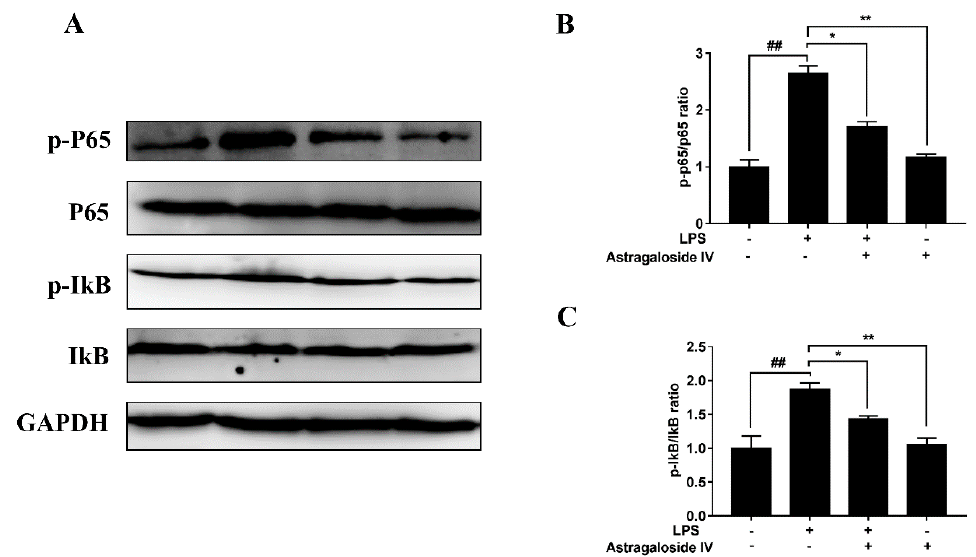
Figure 8. Effects of Astragaloside IV on LPS-induced activation of NF- κ B signal pathways in uteri. Protein levels were detected by Western blotting. Relative protein levels were analyzed by grey scanning. The data are shown as mean ± SD, n = 3; *, p < 0.05; **, p < 0.01. ## indicates a significant difference from the LPS − /AS IV − group ( p < 0.01).